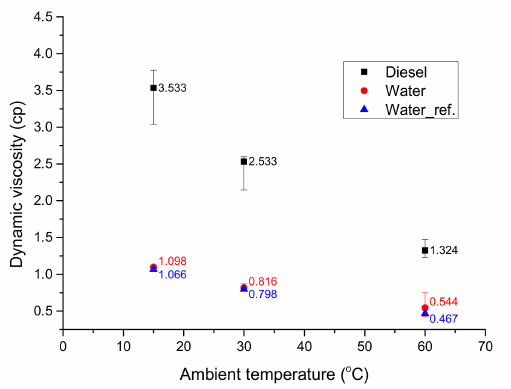
Figure 3. Viscosity of diesel and water at various temperatures.